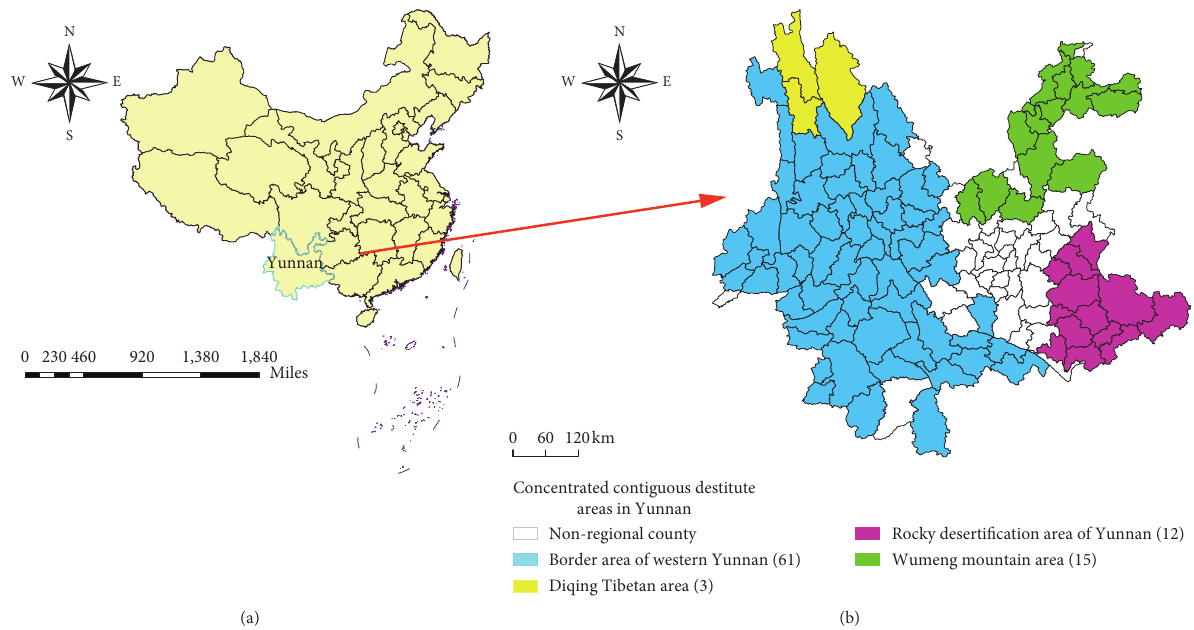
Figure 1: Location of the concentrated contiguous destitute areas of Yunnan,